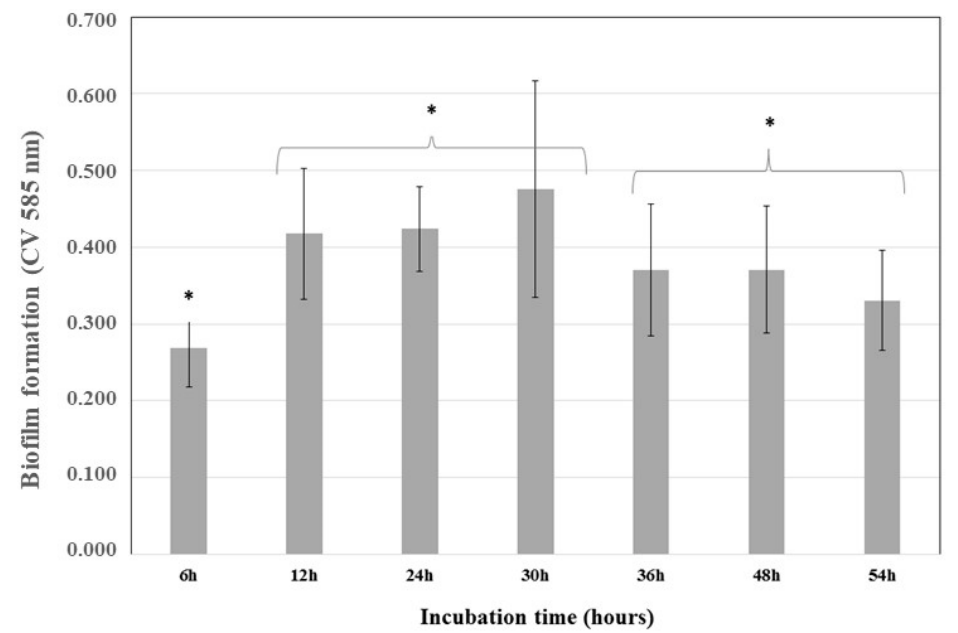
Figure 1. Kinetics of Klebsiella pneumoniae ATCC 13884 biofilm formation. K. pneumoniae ATCC 13884 was incubated for 54 h and the biofilm was analyzed at 6, 12, 24, 30, 36, 48, and 54 h to determinate the best time for maximum biofilm formation. The highest value was 30 h and indicated the time required to obtain a mature biofilm. * Statistically significant differences were observed for 6 h, 12–30 h, and 36–54 h (* p < 0.05) ( n = 15).